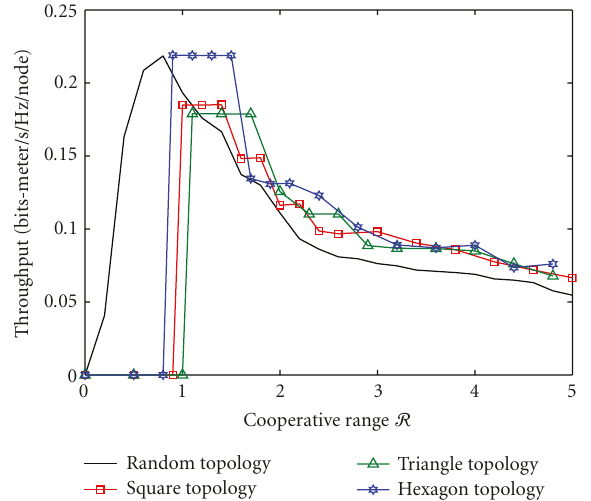
Figure 11: Throughput of D-SAM versus the cooperative range R . We used ρ = 1, ζ = 1, SNR = 40dB, and SISO channels.